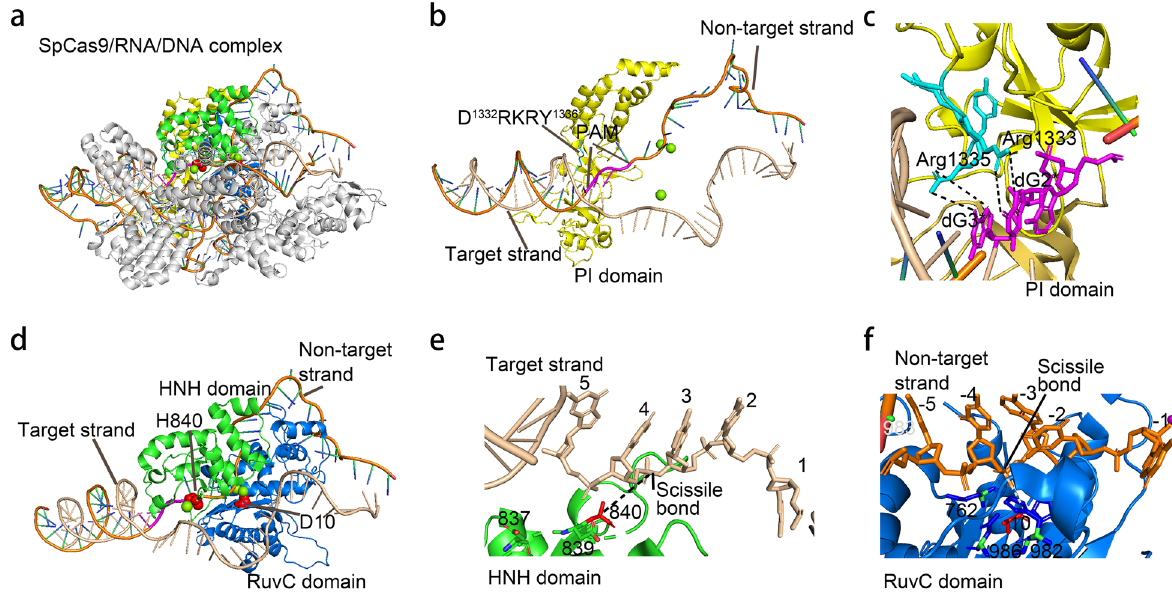
Fig. 1 Structure of spCas9/sgRNA/DNA complex. a Overall structure of spCas9/sgRNA/DNA complex, with PI, HNH and RuvC domains shown in yellow, green and blue respectively. b and c Detailed structure showing the interaction between PI domain and PAM ( b ), with key amino acids highlighted in pink ( c ). d Detailed structure showing the HNH domain, RuvC domain and target DNA, with key amino acids (D10 and H840) shown in sphere. Mutation of Asparticacid 10 (D10) or Histidine 10 (H840) to Alanine (A) silences the RuvC or the HNH domain respectively, resulting in TS nickase or NTS nickase respectively. Mutation of both amino acids silences both domains, resulting in catalytic dead Cas9. e Detailed structure showing the key amino acids interaction with target strand in HNH domain. f Detailed structure showing the key amino acids interaction with target strand in RuvC